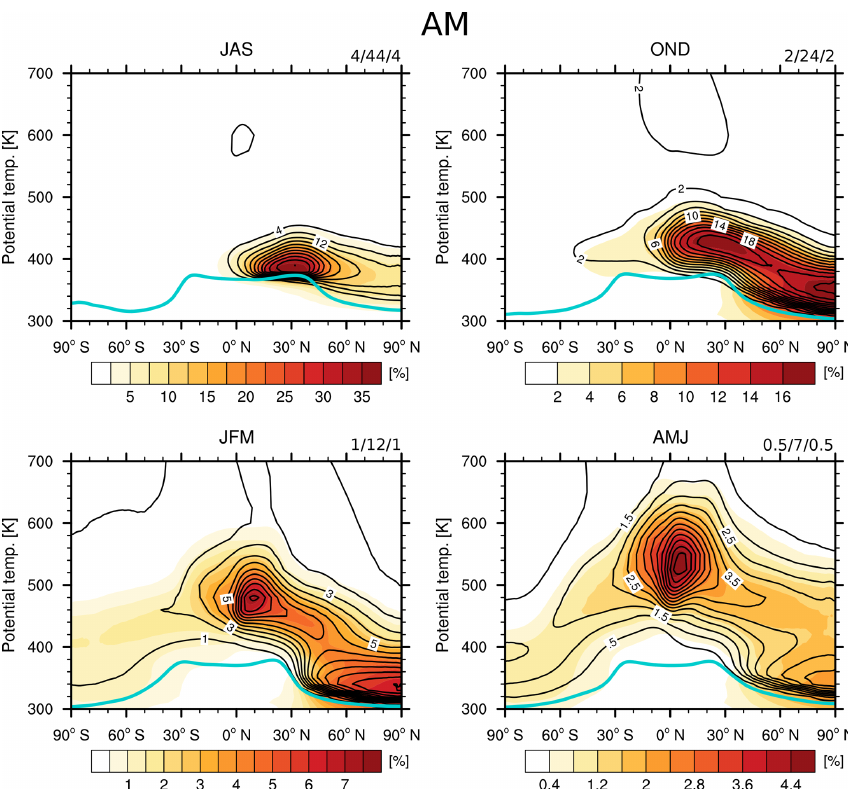
Figure 4. Climatology of mean mass (colour-coded) and relative water vapour (contours) contribution of the AM tracer (both in %) over the course of a year. Note that each season features an individual colour bar with high (low) contributions coloured in red (yellow to white). Numbers in the top right corner of each panel indicate the contour line spacing as min/max/delta. The light blue lines represent the mean WMO tropopause based on ERA-Interim data. The main characteristics of mass transport from the AM tracer are similar to transport from the core of the Asian monsoon anticyclone as displayed in Fig. 1 of Ploeger et al.